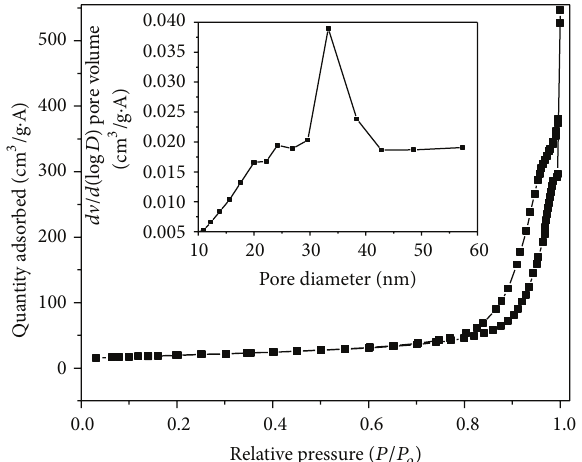
Figure5:Nitrogenadsorption-desorptionisothermoftitanianano- catalysts.